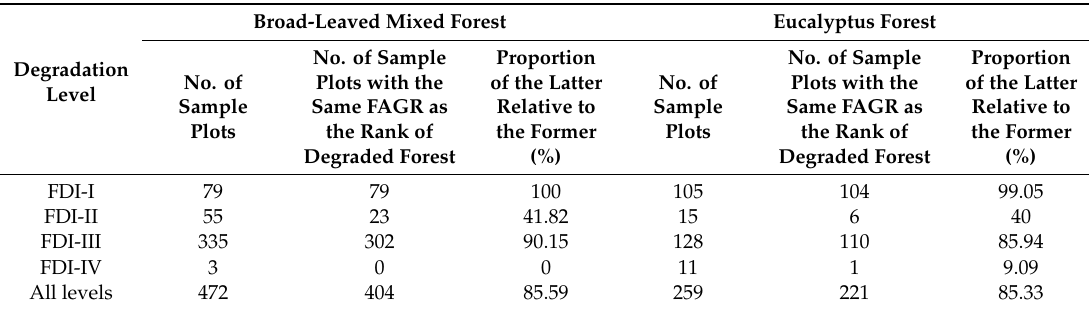
Table 7. Relationship between forest degradation level and Forest accumulation growth rate (FAGR) in the Guangdong province (FDI: forest degradation index).